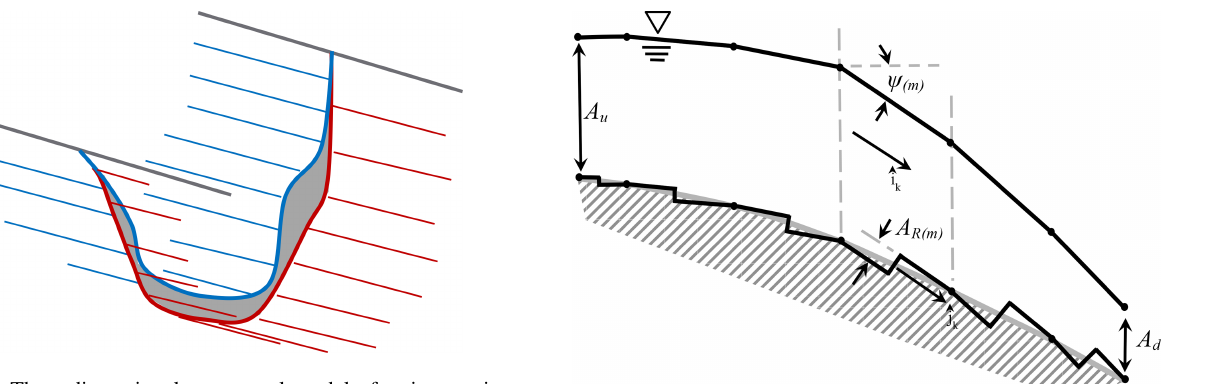
Figure 4. Three-dimensional conceptual model of stair-step riser (gray) as a 2-D planar area of A R (m) separating two tread areas (blue, red).